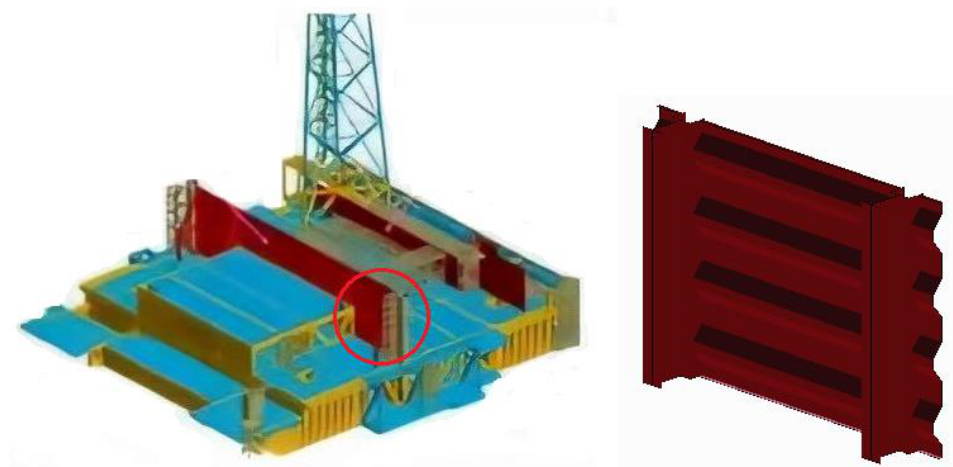
Figure 1. A usual design of the corrugated blast wall (CBW) in offshore platforms.